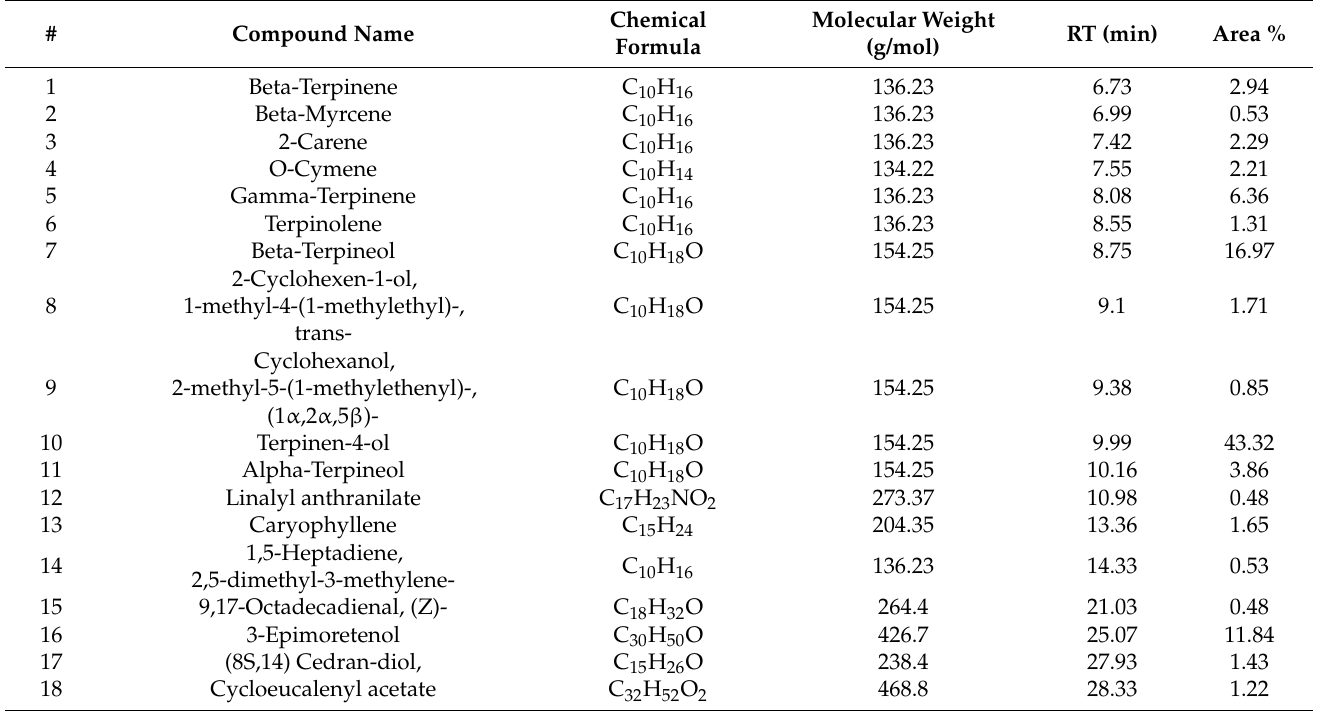
Table 2. The chemical composition of Origanum vulgare essential oil using GC-MS